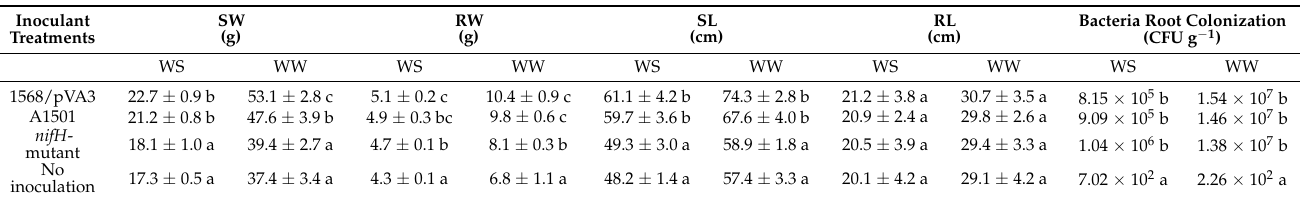
Table 2. Shoot weight (SW), root weight (RW), shoot length (SL), root length (RL) and most prob- able number (MPN) of the P. stutzeri A1501 wild-type strain or mutants on roots in a greenhouse experiment under two water regimes. The values are mean ± standard deviations (n = 16). Different letters (a–c) indicate a significant difference ( p < 0.05) according to ANOVA analysis. WS—water stress condition; WW—well-watered